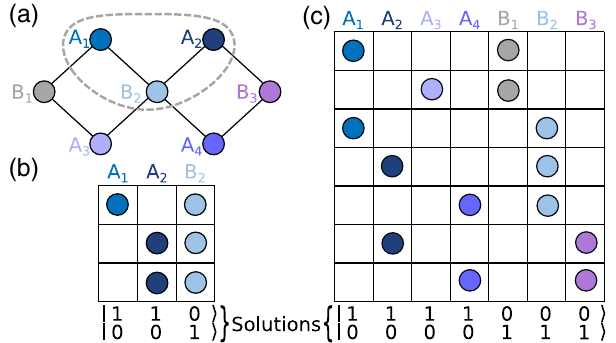
FIG. 2. (a) Hardware connectivity graph of the quantum device. Dots correspond to qubits and edges indicate between which pairs of qubits two-qubit gates can be realized. The gray dashed line indicates the subset of qubits used for the three-qubit problem instance depicted in (b). (b) Visual representation of the incidence matrix K (dots indicating entries K (cid:7) i = 1) for a cho- sen three-qubit exact-cover problem instance. The labels above the columns (and the colors) indicate which physical qubits are used to represent the corresponding subset. The two solution states are indicated below the grid. (c) Visual representation of the incidence matrix for a chosen seven-qubit problem